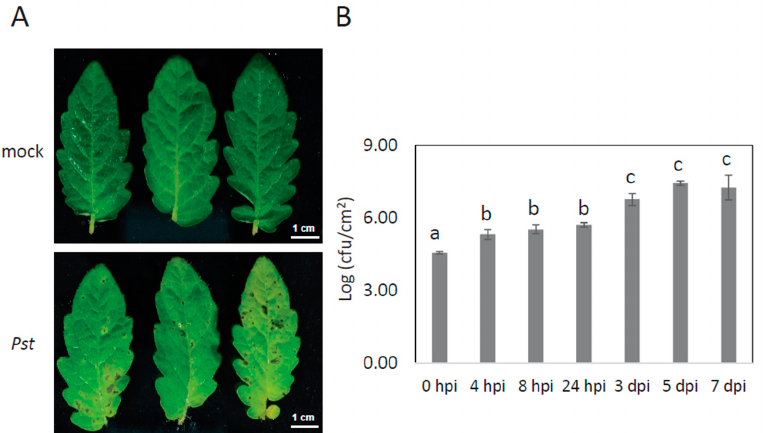
Figure 1. Disease phenotypes and population dynamics of Pst DC3000 on tomato leaves. ( A ) Visible disease symptoms in tomato leaves after leaves were dipped into bacterial suspension at an OD 600 of 0.02. Photos were taken at 5 days post-inoculation. ( B ) Bacteria titres in leaves at 0, 4, 8, 24 h or 3, 5, 7 days after inoculation with Pst DC3000. Error bars represent the standard deviation of three biological replicates. A statistical significance difference is shown between different time points using analysis of variance (ANOVA) with post-hoc Tukey’s honestly significant difference (HSD) test by labelling bars with different lowercase letter (a, b, and c).